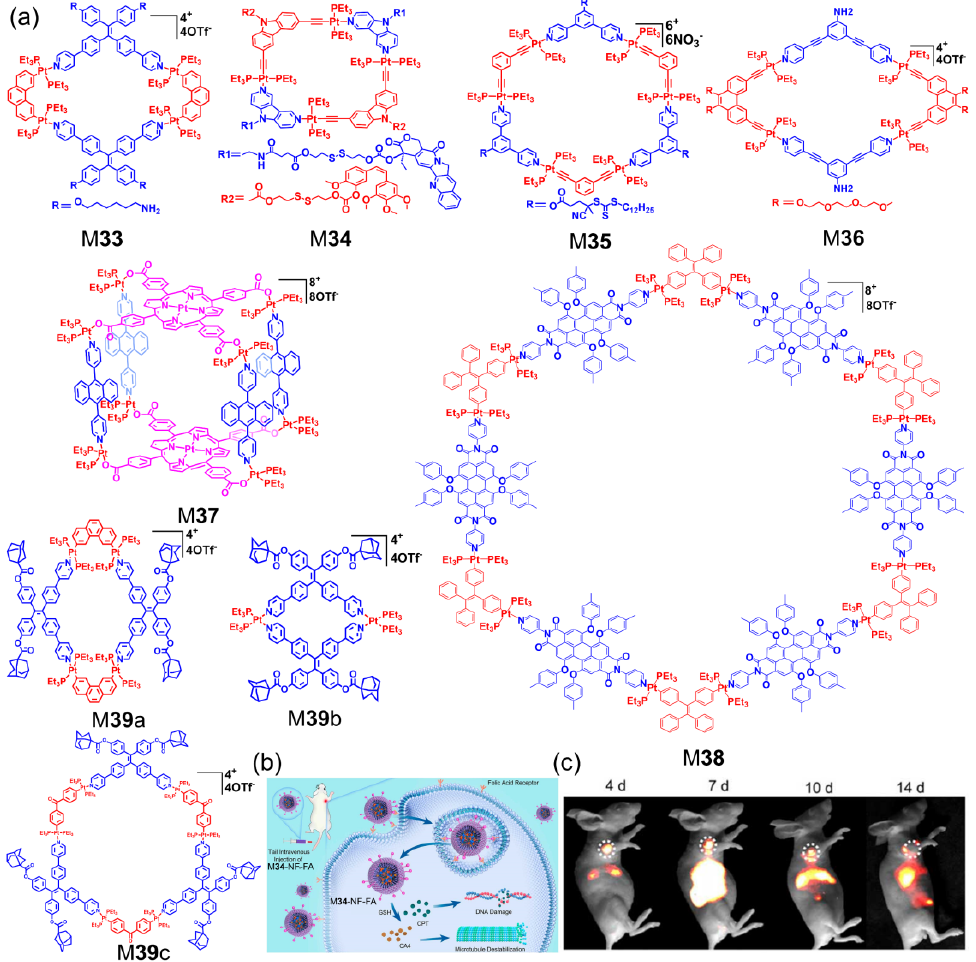
Figure 7. ( a ) The structures of M 33 − M 39 . ( b ) The cellular uptake of M 34 -NF-FA and the intracellular release of drugs in response to GSH. ( c ) NIR-II fluorescence images detecting M 36 in tumors.